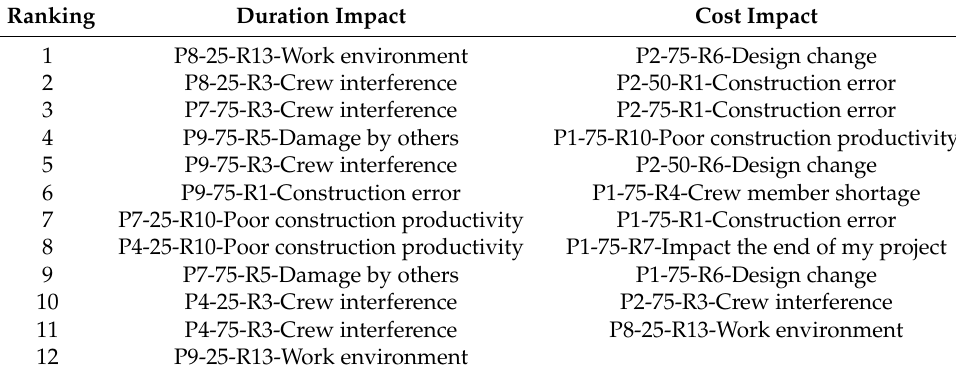
Table 2. Ranking of the main overlapping risks impacting the total project duration or cost (ten simulation runs). Modified from [37].